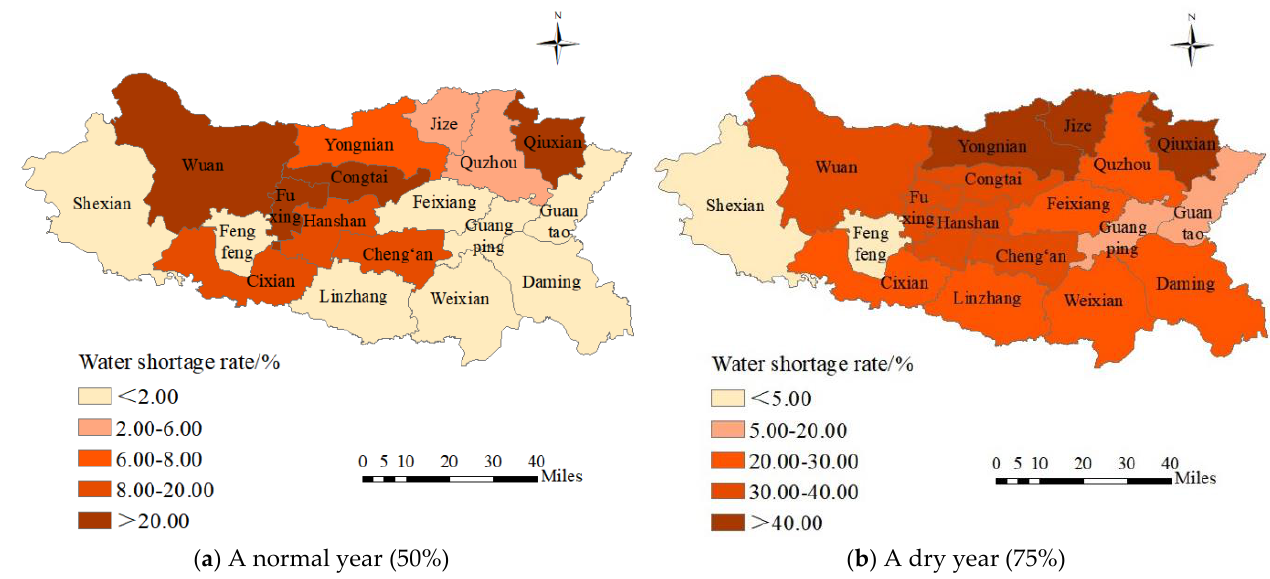
Figure 11. Water shortage rate in 2025.